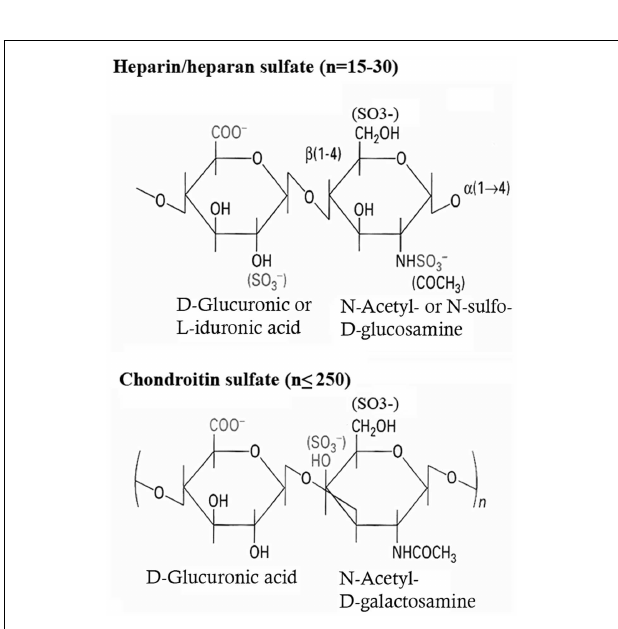
FIGURE 1 |The syndecan family . Schematic illustration of structurally related syndecan genes, showing the two subfamilies of syndecans: syndecan-1 and -3, and syndecans -2 and -4, respectively.The extracellular domain is highly